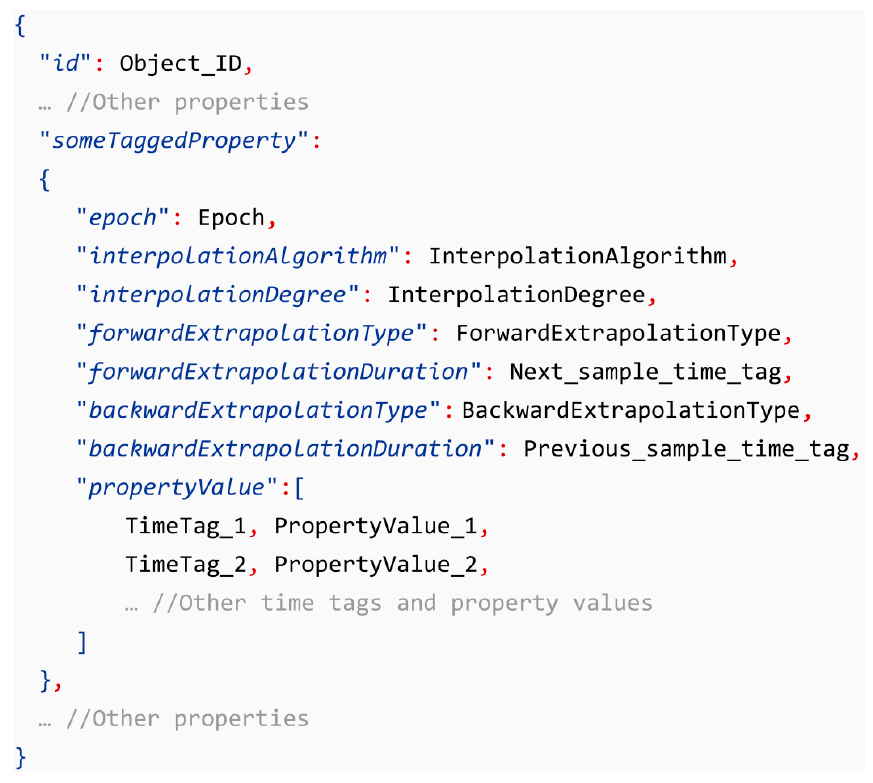
Figure 4. General structure of specifying an interpolatable time-varying property using time tags.